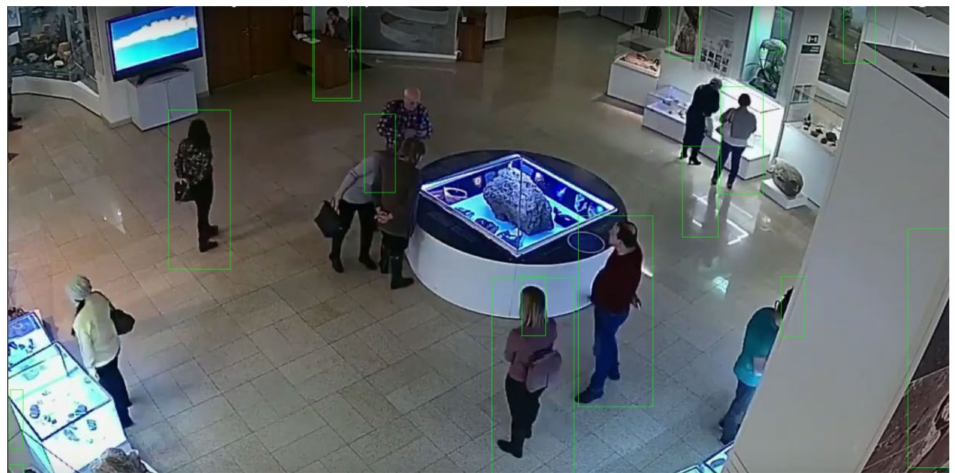
Figure 8. The detection logic output for a video stream of a Russian museum. The scatter plot of the detected figures is shown in Figure